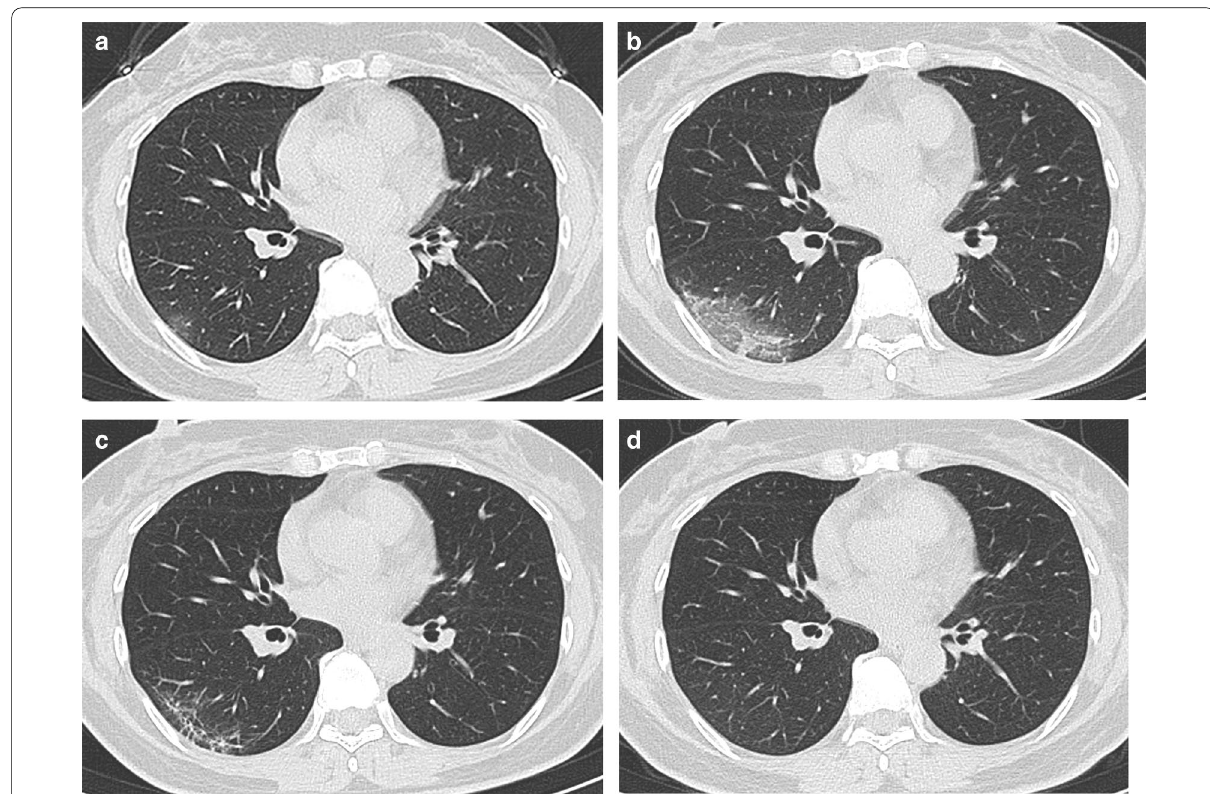
Fig. 3 Female, 50‑year‑old, COVID‑19. a The initial CT obtained 4 days from onset of symptoms shows the round ground‑glass opacity around the subpleural area of the right lower lobe. b The peak CT obtained 6 days later shows the large patchy ground‑glass opacity and a few of consolidation around the subpleural area of the right lower lobe. c The pre‑discharge CT obtained 14 days later shows reticulation, irregular lines, and pleura thickening. d . Axial CT. The follow‑up CT obtained 64 days later shows a normal chest